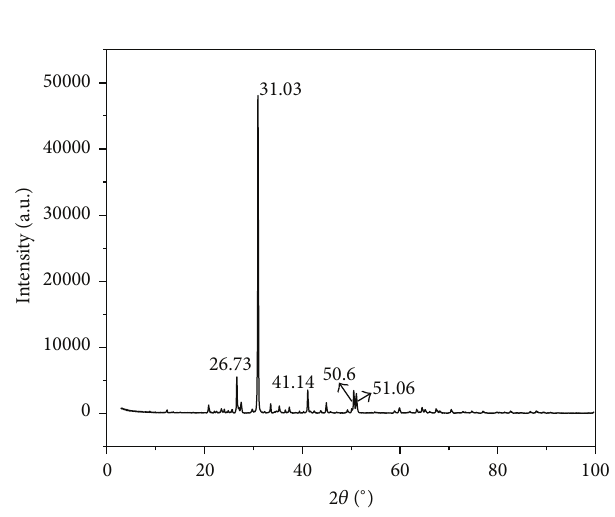
Figure 3: XRD of Gu Haiyan.